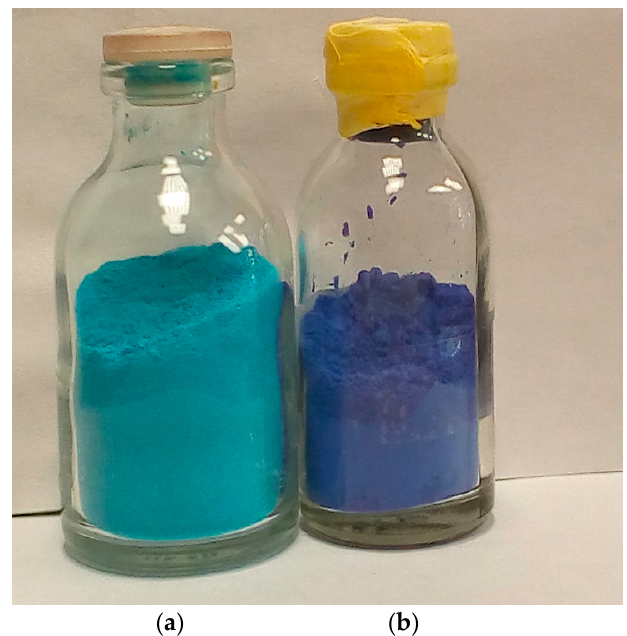
Figure 3. ( a ) Cu 3 (BTC) 2. 2H 2 O powder and ( b ) Cu 3 (BTC) 2 obtained by heating to 180 °C for 30 min in